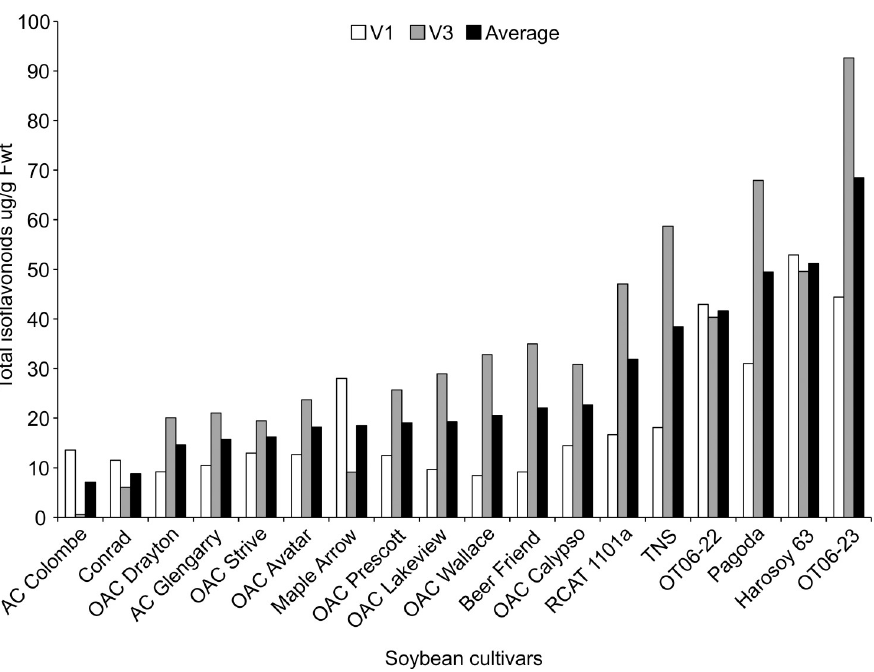
Fig 1. Total isoflavonoid concentration in the top trifoliate leaves of 18 soybean cultivars at the V1 and V3 growth stages and the mean concentration of both stages. The concentration of isoflavonoids in the top leaves was used to categorize the soybean cultivar as low, medium or high.